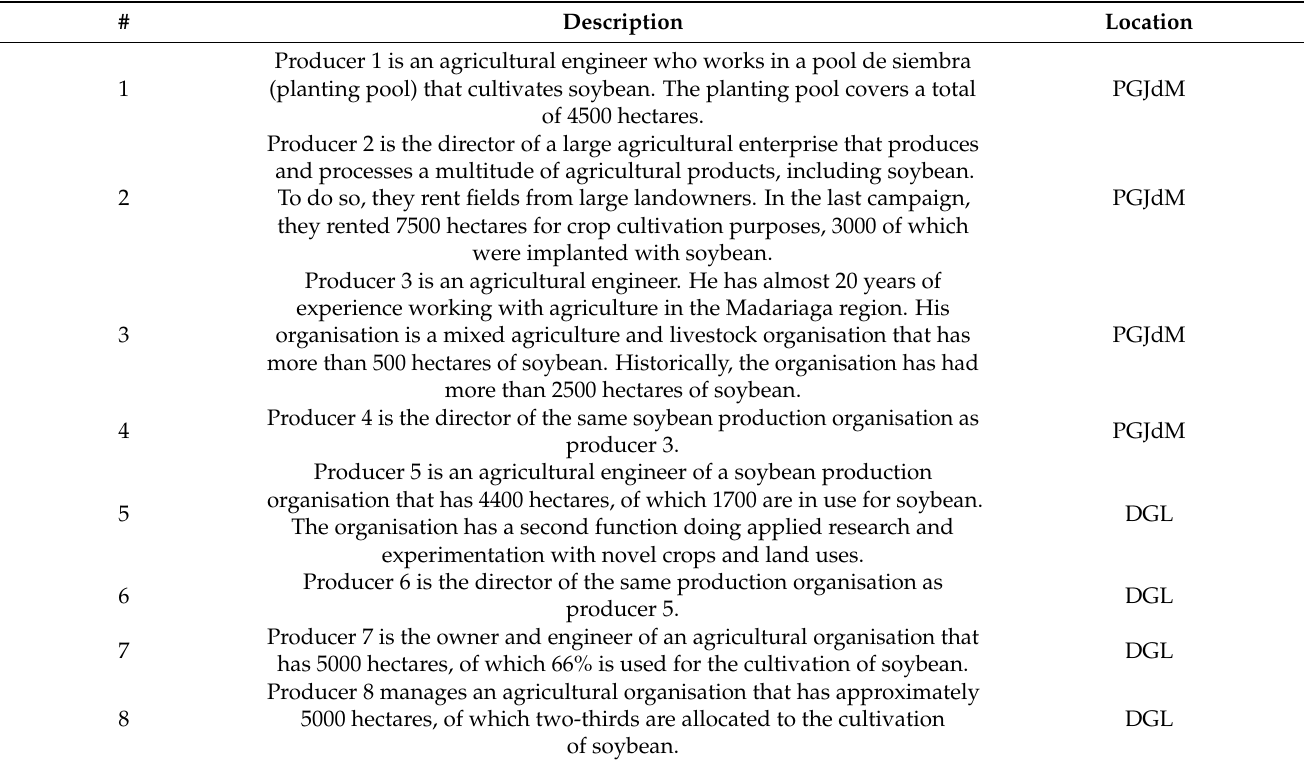
Table A2. Characteristics of the soybean producers interviewed in this research.